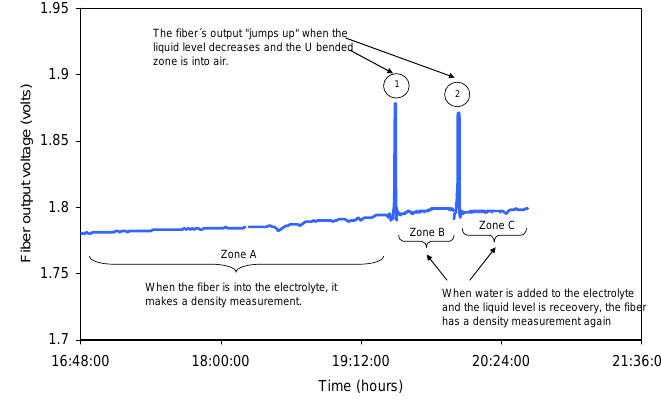
Figure 18. Response of the level fiber as the level of electrolyte